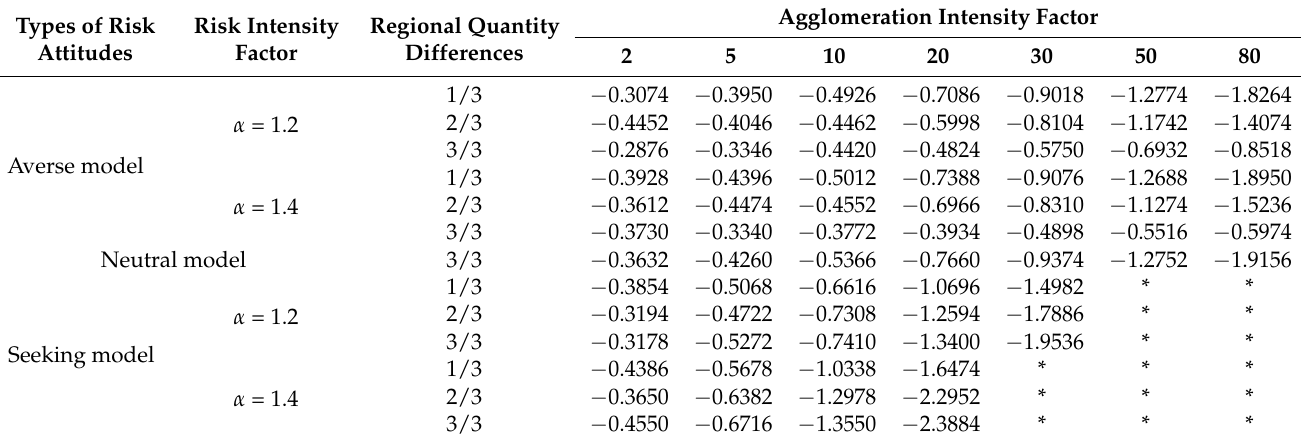
Table 3. Comparison of the slopes of different scenes.